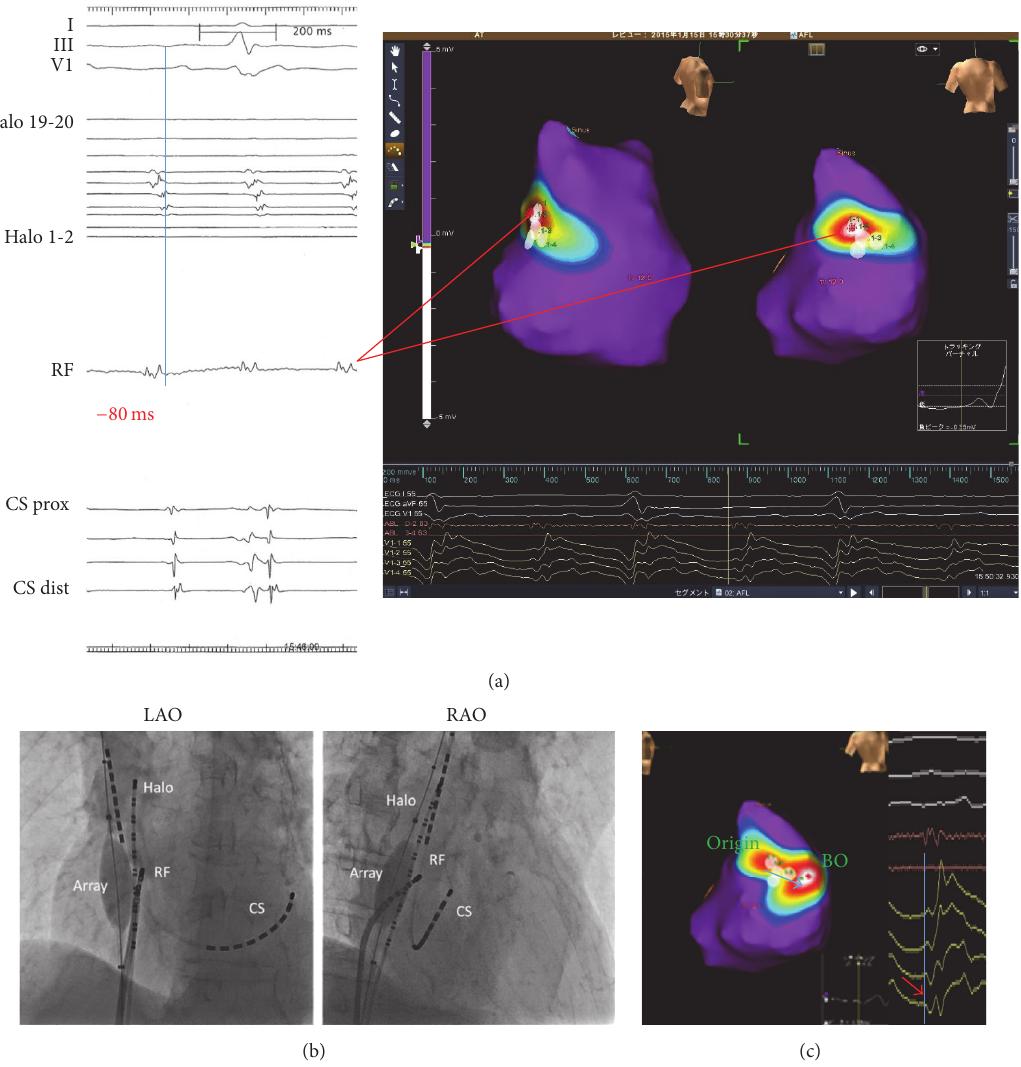
Figure 3: (a) Double potentials were recorded and preceded the onset of P wave by 80 ms. (b) Catheter position at RF site. RF catheter was locatedatposteriormedialwall.RF:ablationcatheter;CS:coronarysinus;prox:proximal;dist:distal.(c)Thenoncontactunipolarelectrogram revealed a QS pattern of the origin (red allow). The length of preferential pathway (blue arrow) was 8 mm. BO = breakout site of